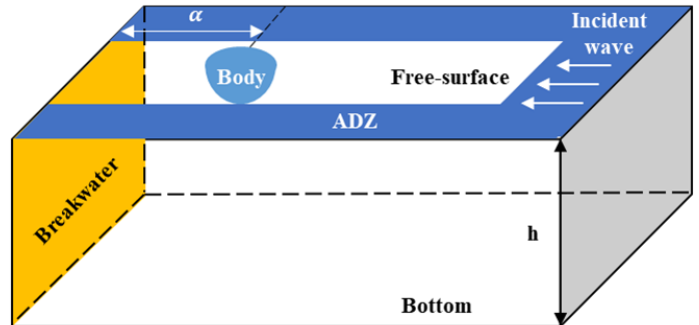
Figure 14. Overview of the computation domain with a WEC and breakwater (yellow: seawall-type breakwater, blue: ADZ).